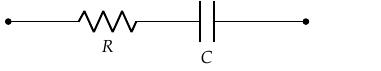
Figure 2. A resistive-capacitive